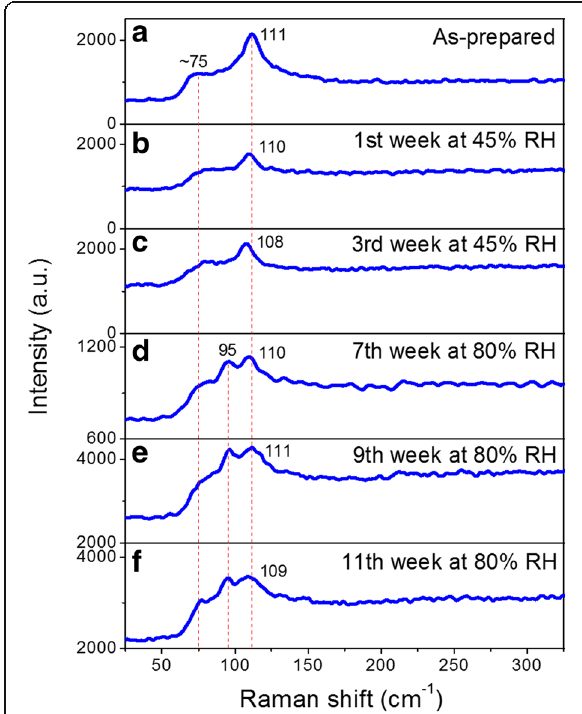
Fig. 3 Raman spectra evolution of MAPbI 3 MWs after humidity exposure. a As-prepared sample, after b 1 week and c 3 weeks at 45% RH and after the d 7th, e 9th, and f 11th weeks at 80% RH. Spectra measured in ambient air with an excitation wavelength of 532 nm, an incident power of 16 μ W, an acquisition time of 10 s, and a laser spot diameter of ~ 1 μ m on the